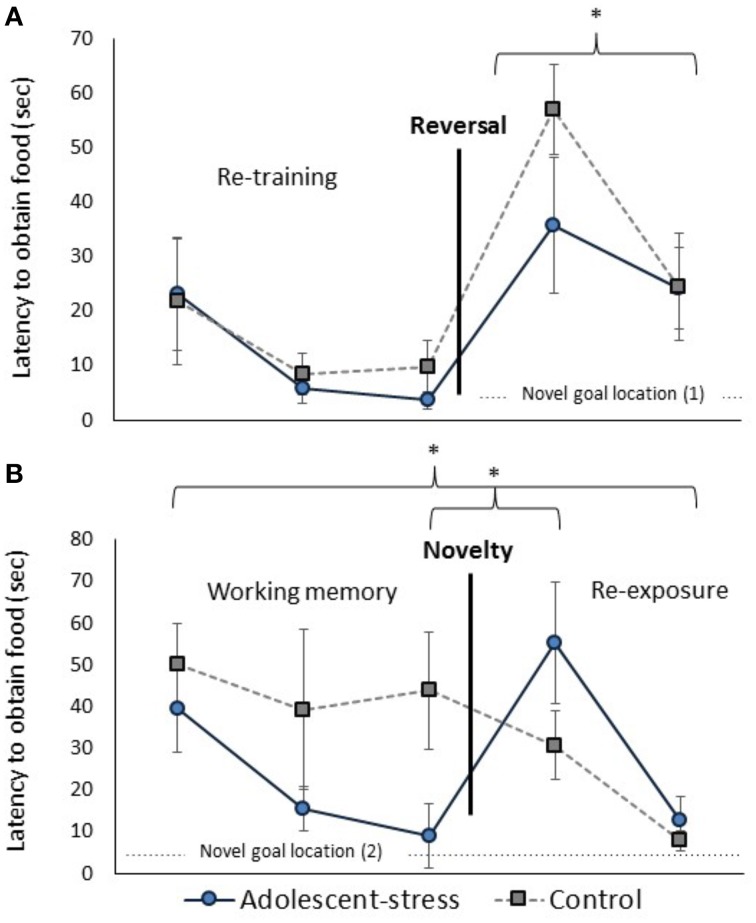
The effect of stress during adolescence on reversal learning (A) and working memory (B) in adulthood, measured by the latency to obtain the reward. Asterisks indicates p ≤ 0.05; means ± standard error.